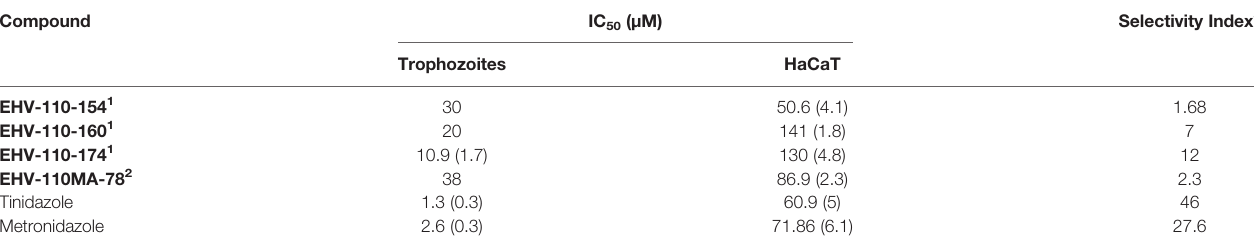
Standard deviation values are in parenthesis. 1